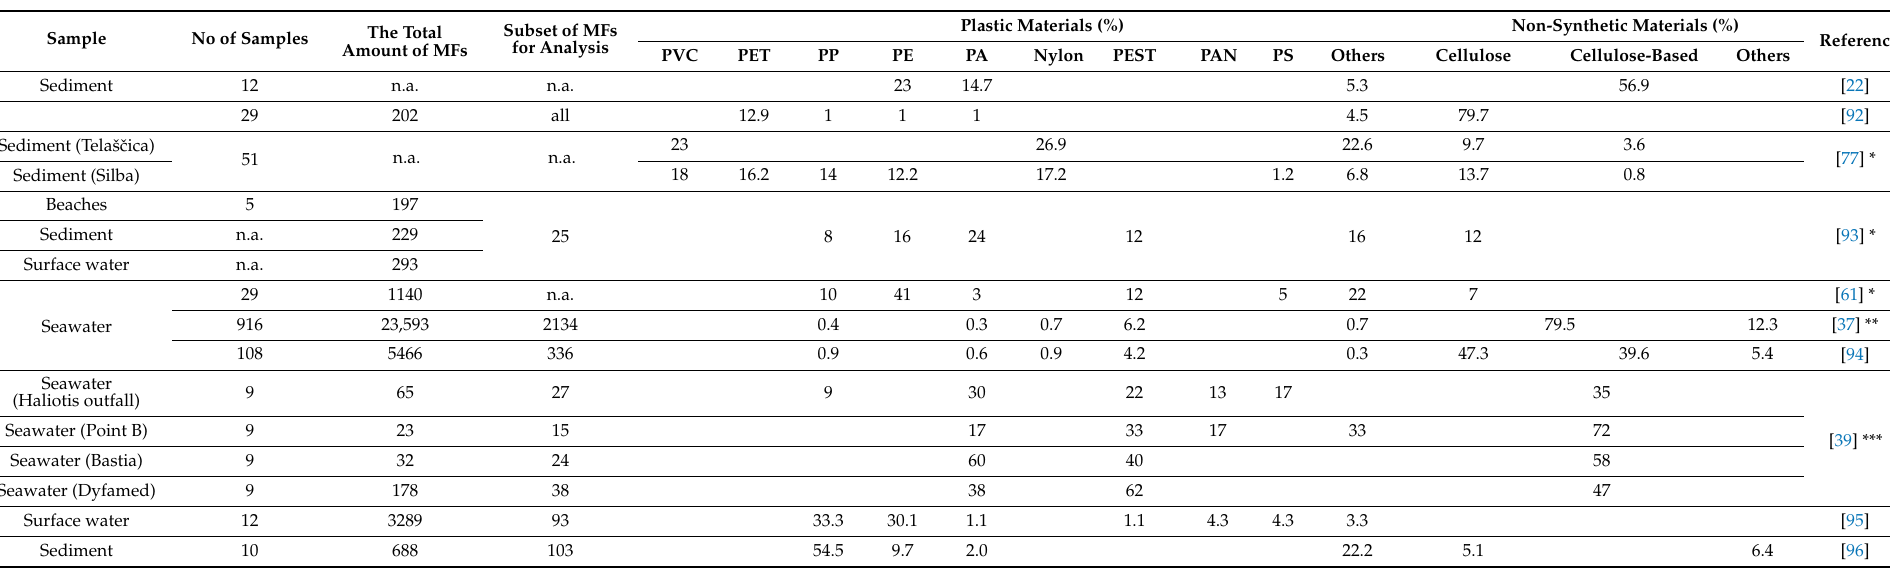
Table 4. The literature data on the abundance of natural (i.e. , cellulose), artificial (i.e. , cellulose-based), other non-synthetic (i.e. , wool, silk) and plastic microfibers in the sediment and water column from the Mediterranean Sea, together with the number of specimens sampled and the relative number of fibers found and